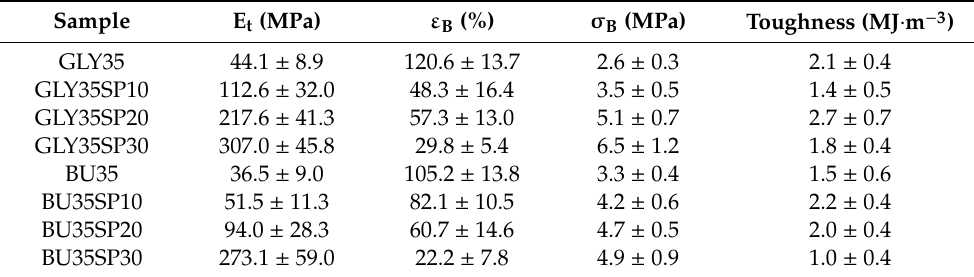
Elastic modulus (E t ), elongation at break ( ε b ), stress at break ( σ b ), and toughness values of samples plasticized with 35% glycerol and 1,4-butanediol, with 0, 10, 20, and 30 php of microalgal biomass. Sample E t (MPa) ε B (%) σ B